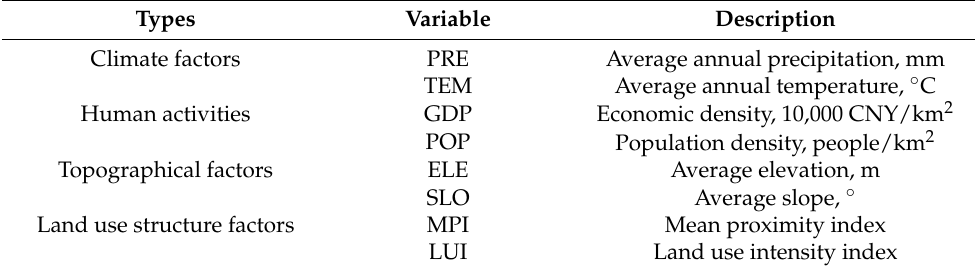
Table 1. Classification and description of ESV influencing